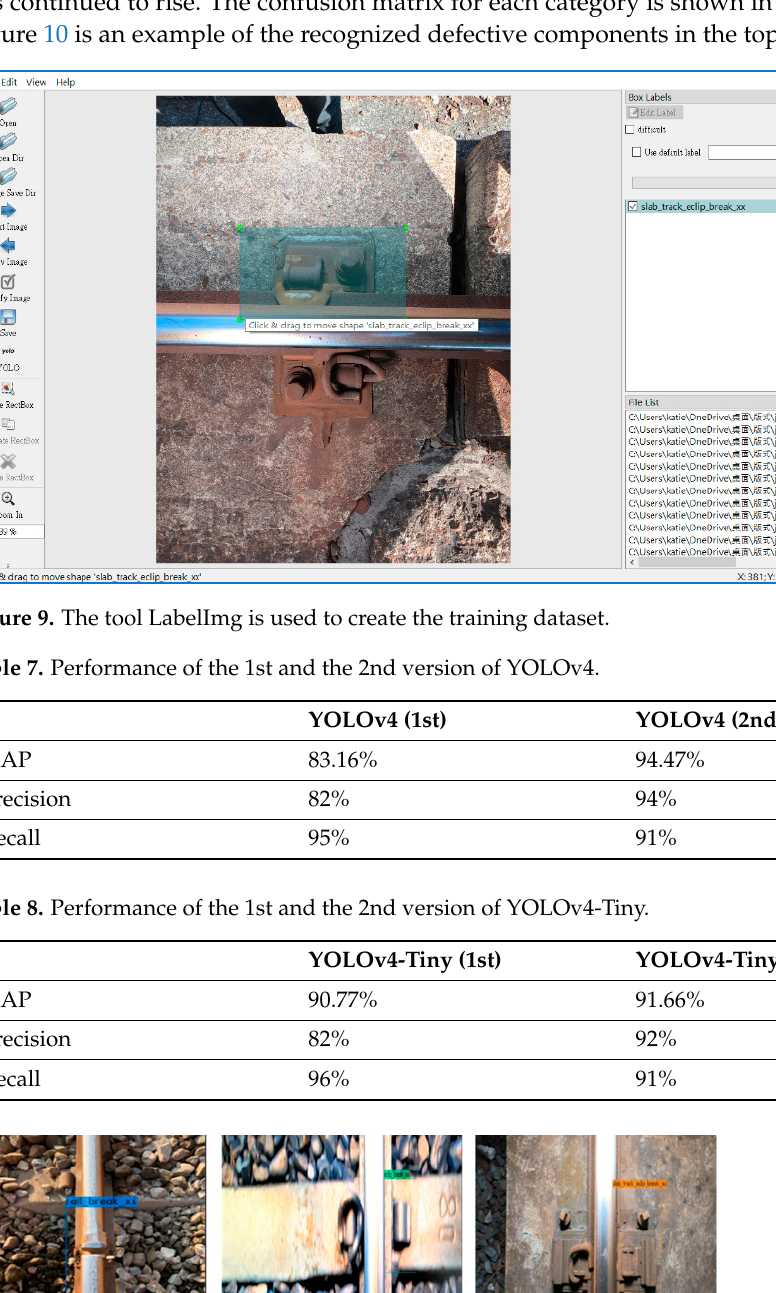
Table 7. Performance of the 1st and the 2nd version of YOLOv4.